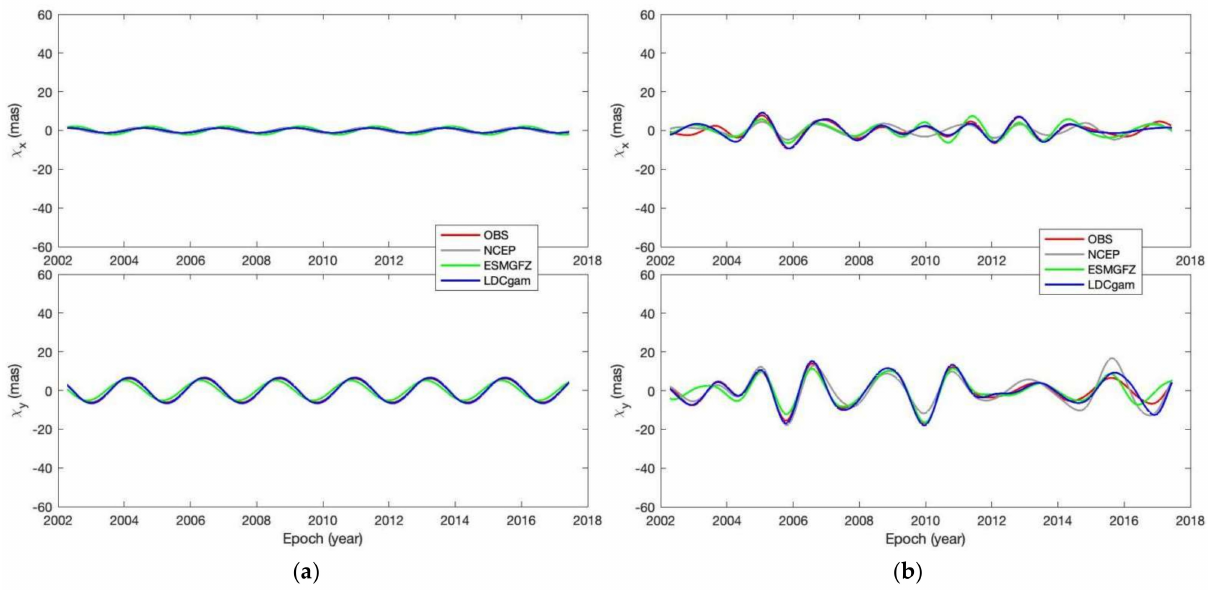
Figure 5. Quasi-biennial PM excitations. ( a ) Harmonic fitting according to Equation (2); ( b ) wavelet analyses based on the coif5 wavelet, as shown in Figure